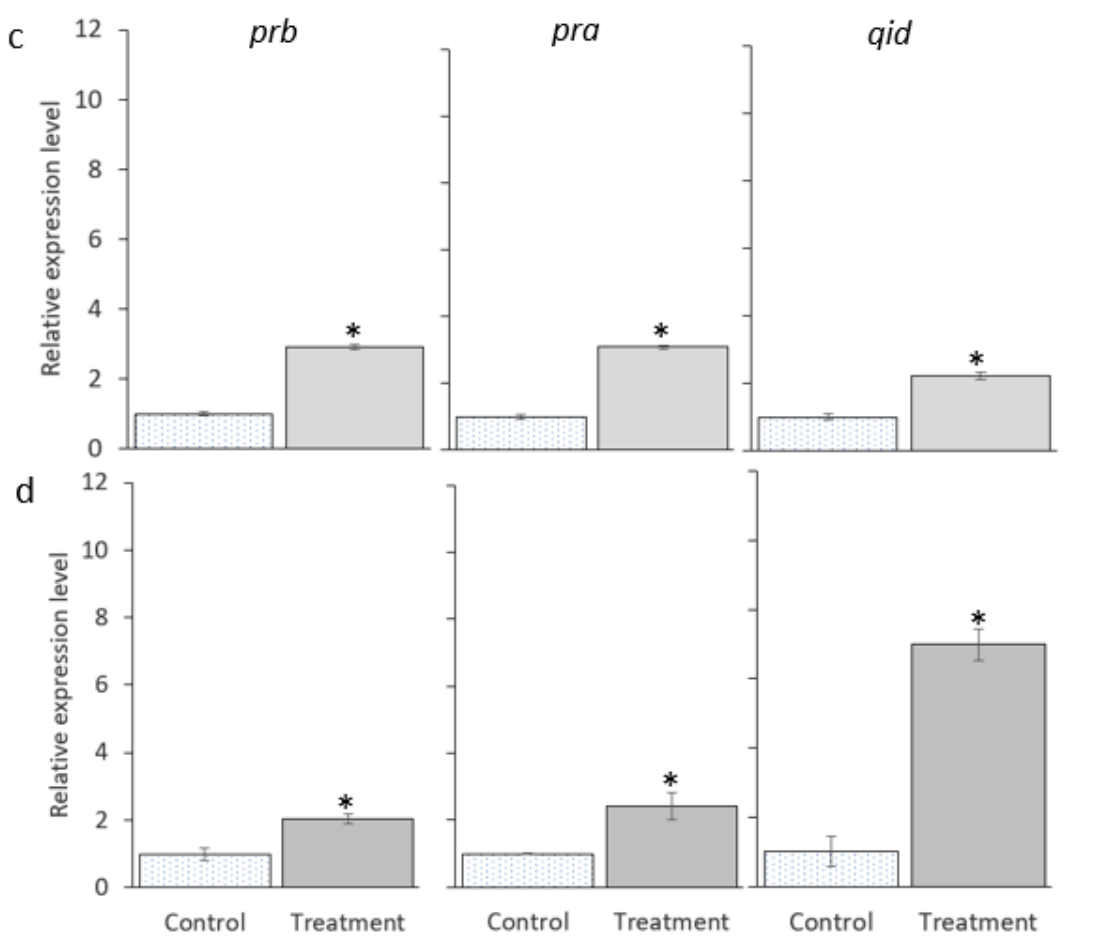
Figure 6. Expression patterns of biocontrol-associated genes after confrontation with P. noxium strain B in ( a , c ) Trichoderma strain #5001 and ( b , d ) Trichoderma strain #5029. Elongation factor 1 − α and β − actin genes ( tef and act , respectively) were used as references to normalize biological control associated genes expression in Trichoderma strain #5001 and #5029. Asterisks indicate significant differences by Student’s t -test ( p < 0.05).